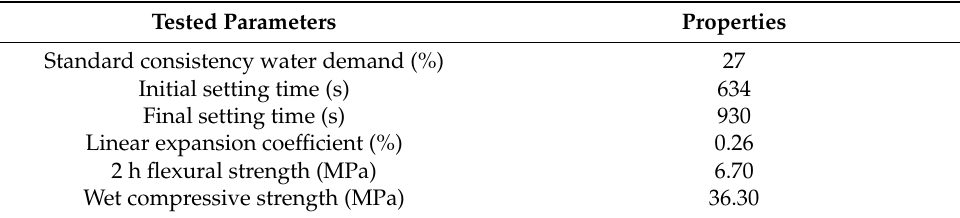
Table 3. Physical property of α -dental gypsum used in this paper. Tested